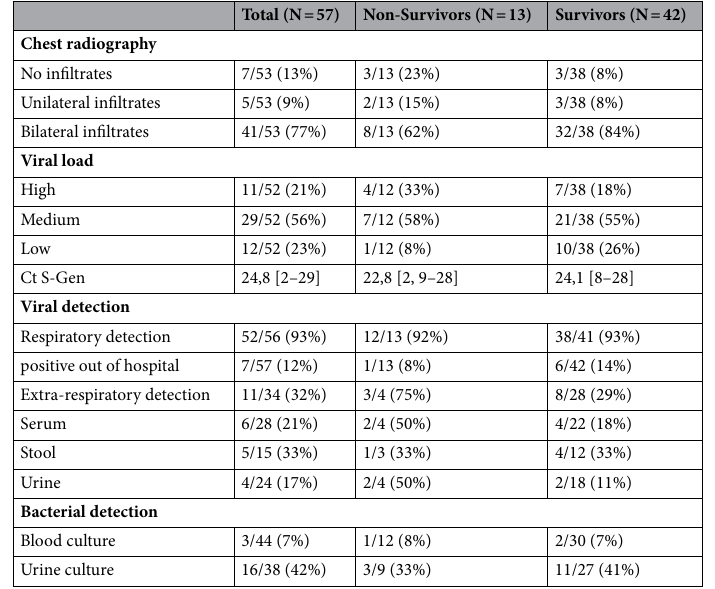
Table 4. Radiological and microbiological findings. Data in N/total available N (%), or Median [IQR] IQR, Interquartile